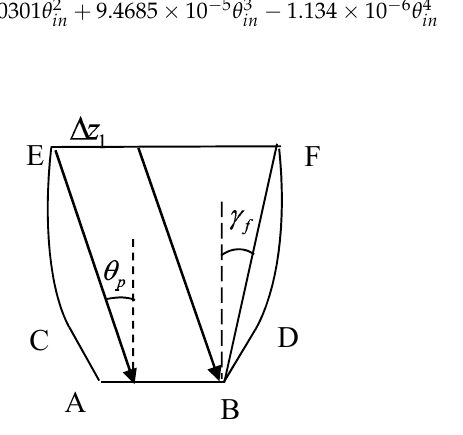
Figure 4. Fraction of radiation directly irradiating on solar Figure 4 . Fraction of radiation directly irradiating on solar cells.